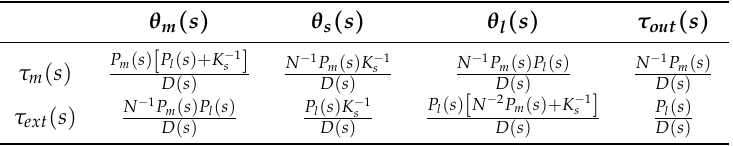
Figure 10. Dynamic modelling of FSEA. ( a ) Free-body diagrams of FSEA and ( b ) block diagram representation of FSEA dynamics. Table 1. Transfer functions of